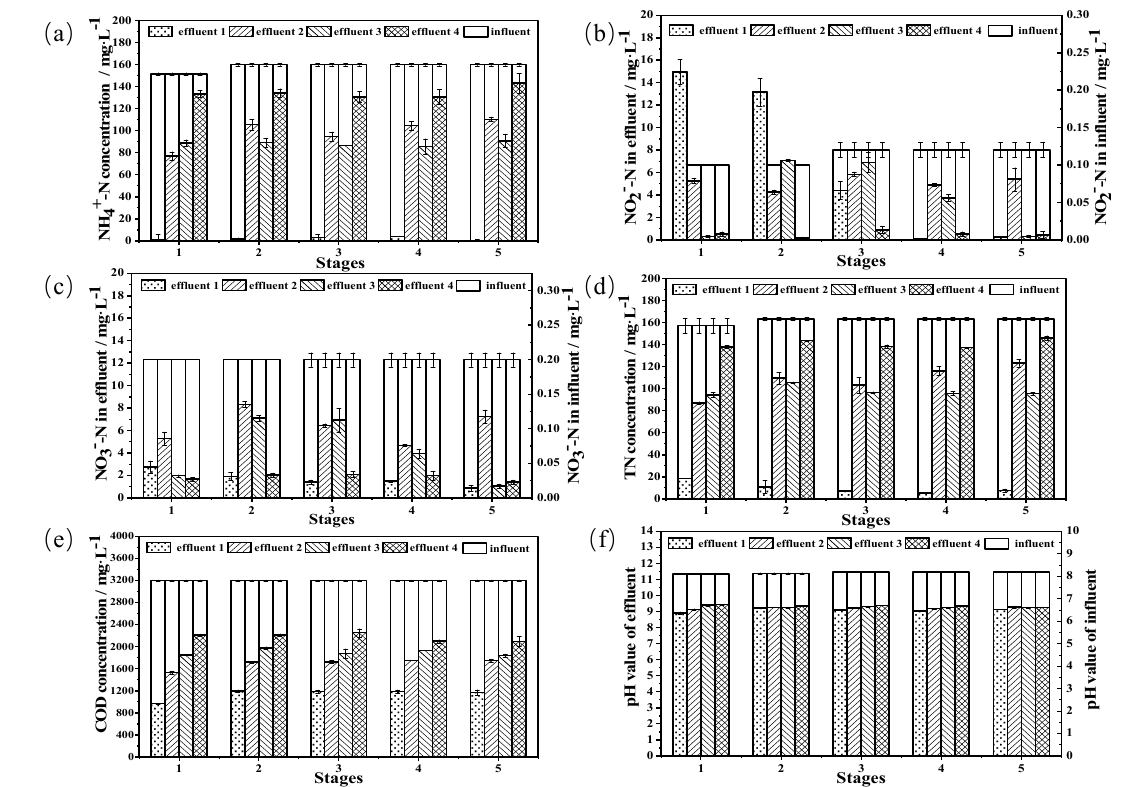
Figure 6. Immobilized cell treatment of actual high-ammonia-nitrogen wastewater. ( a ) NH 4+ -N concentration, ( b ) NO 2 − -N concentration, ( c ) NO 3 − -N concentration, ( d ) TN concentration, ( e ) COD concentration, ( f ) pH. (1 in the figure represents the wastewater and immobilized cell group; 2 repre- sents the wastewater and free cell group; 3 represents the wastewater and modified activated carbon group; 4 represents the wastewater group).